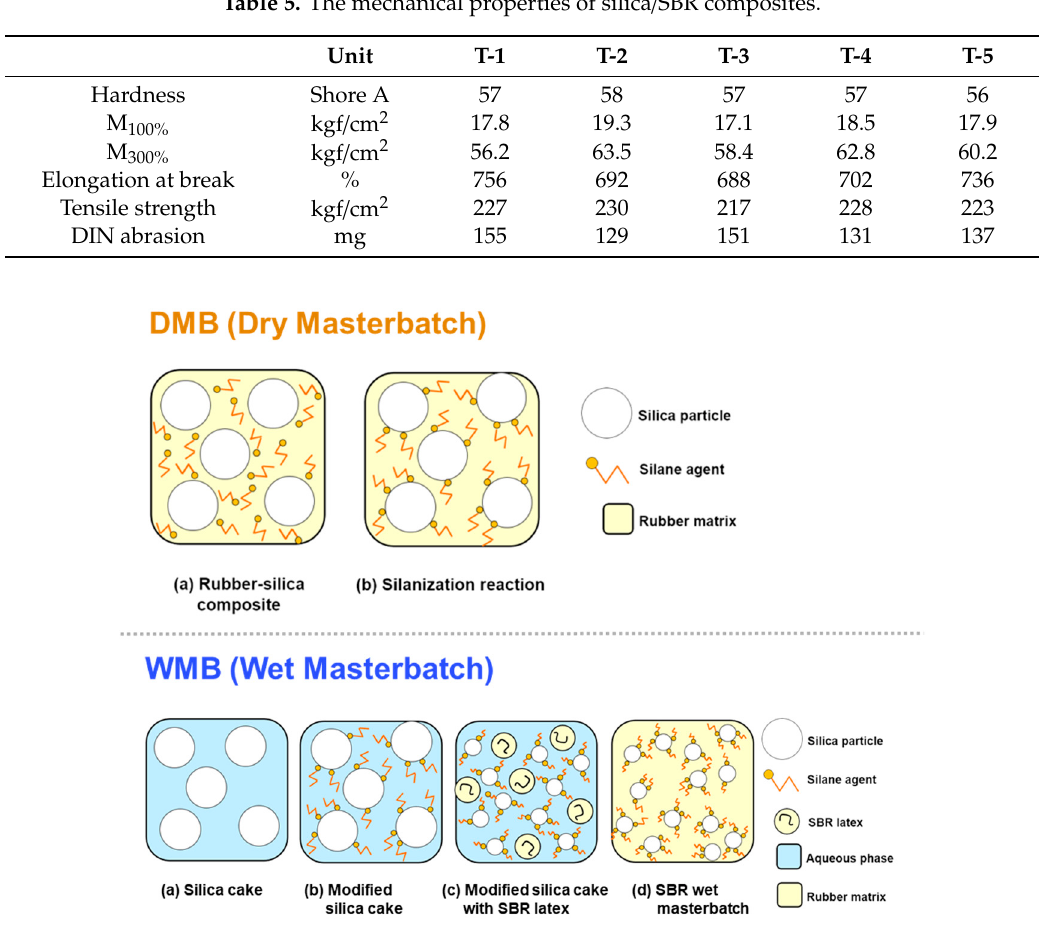
Table 5. The mechanical properties of silica / SBR composites.